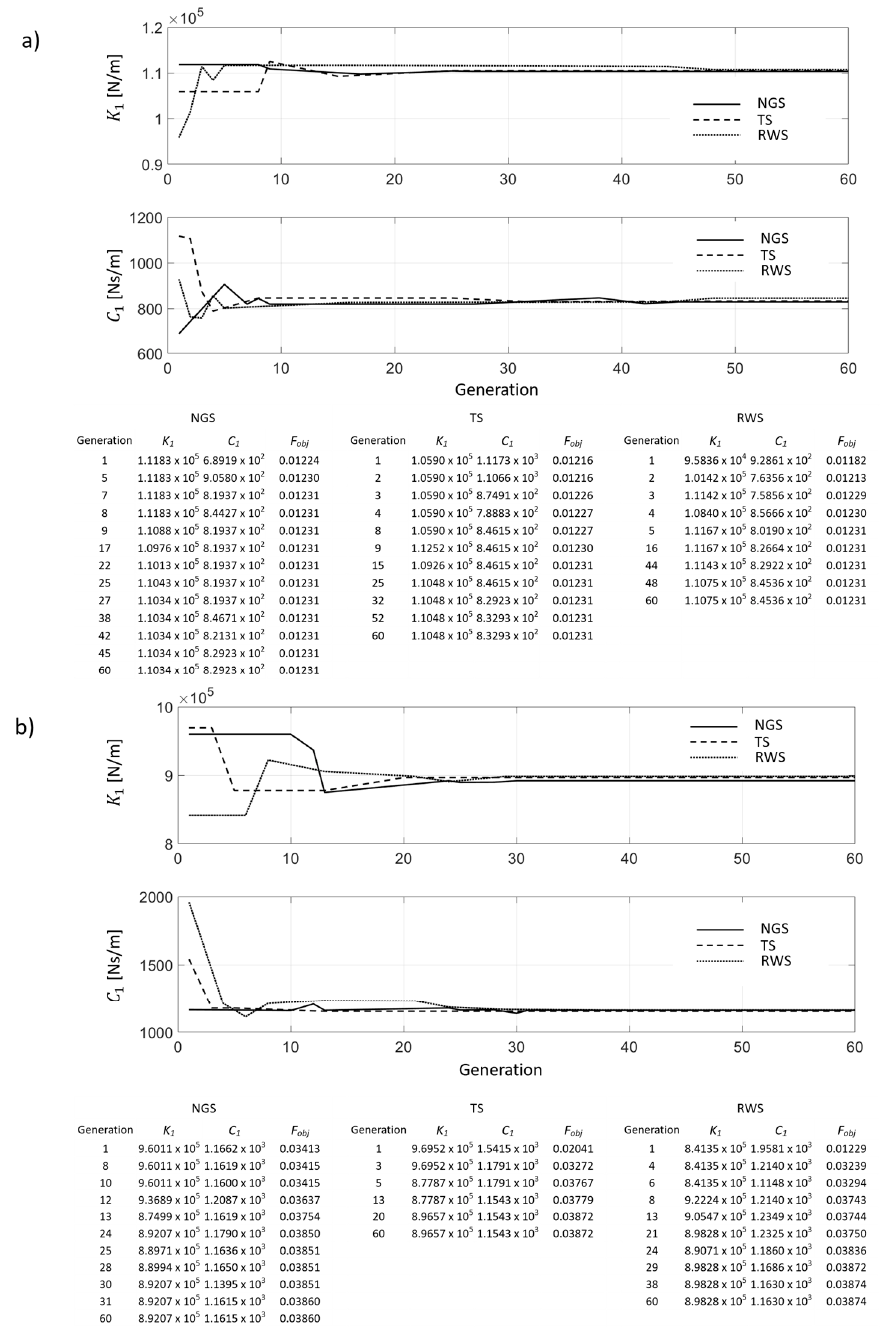
Figure 6. One occurrence of the best population of shaft end side (SES) ( a ) and compressor side (CS) ( b ) damper parameters computed with Normalized Geometric Selection (NGS) (solid line), Tournament Selection (TS) (dashed line) and Roulette Wheel Selection (RWS) (dotted line). The tables report the convergence trend of the best chromosome and their fitness value for each method.